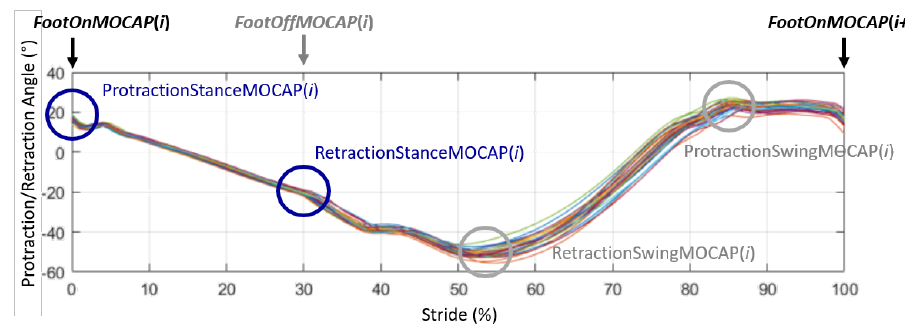
Figure 4. Representation of the canon bone orientation obtained from the MOCAP data for the 26 normalized strides of a trial of one horse trotting at a 4 m/s speed. The maximum and minimum points at each stride, corresponding, respectively, with the ProtractionSwingMOCAP and RetractionSwingMOCAP of the right forelimb, are circled in grey on the Figure. The angles of protraction and retraction at the stance correspond, respectively, with the angles of the canon bone at Foot On and Foot Off, represented by blue circles in the